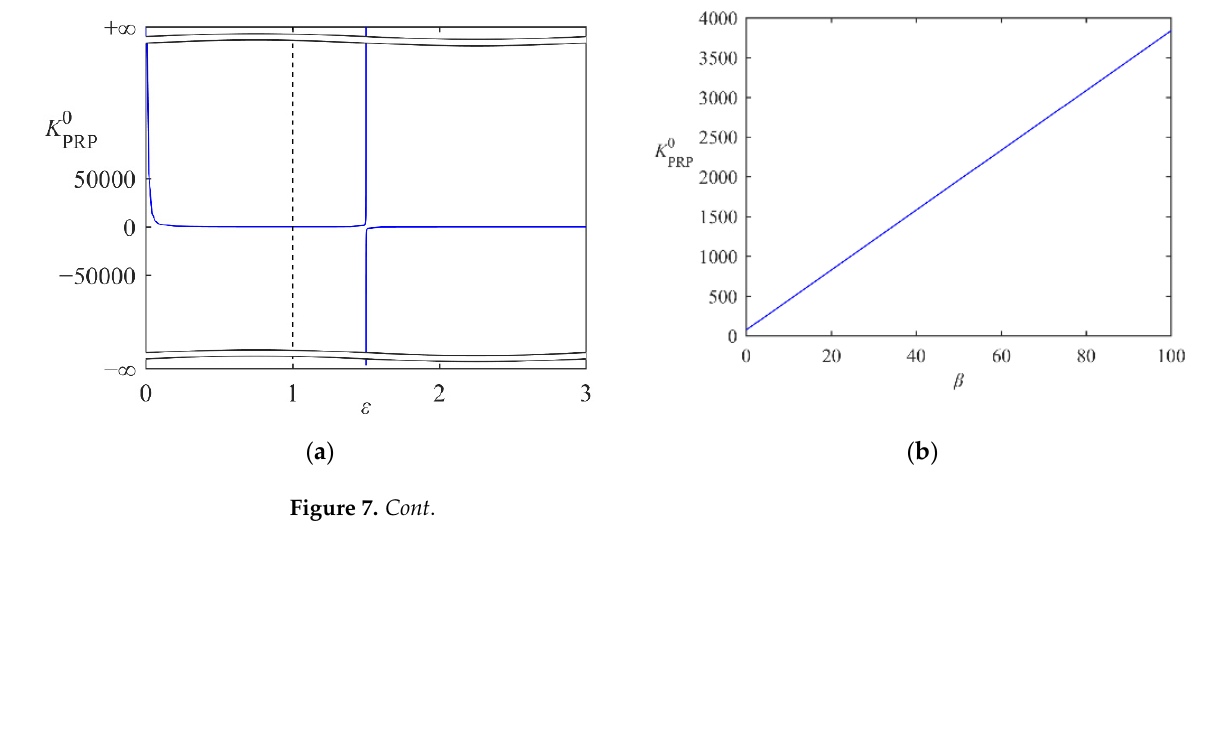
( c ) Figure 7. Analysis of the change of the lowest projection dimensionality K 0PRP with different param- eters. ( a ) The change curve of ε and K 0PRP . (The position of the black dotted line is the inflection point.) ( b ) The change curve of β and K 0PRP . ( c ) The change curve of M and K 0PRP . (The position of the black dotted line is the number of bands.) ( a ) ( b ) Figure 8. Analysis of the change of OA with the number of samplings T and the number of samples in each class H . ( a ) The change curve of T and OA. ( b ) The change curve of H and OA.